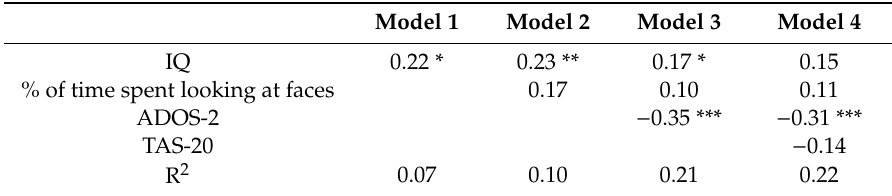
Table 3. Hierarchical regression analysis predicting emotion recognition accuracy from associated demographic variables and psychopathology scores.